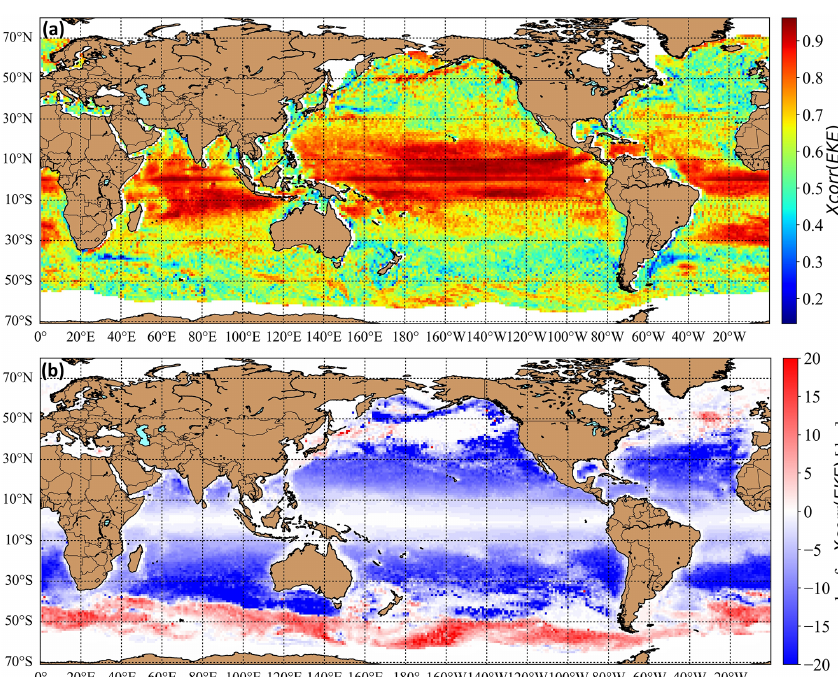
Figure 7. Time-dependent cross-correlation analysis of the EKE field by Eq. (8) for the smallest tiling (5 × 5 grid cells). Only zonal neighbors are considered. The color scales are linear. (a) The level of maximal cross-correlation for each valid tile. (b) The time lag of maximal cross- correlation for each valid tile. Blueish and reddish coloring indicates dominant westward and eastward zonal drifting tendency.